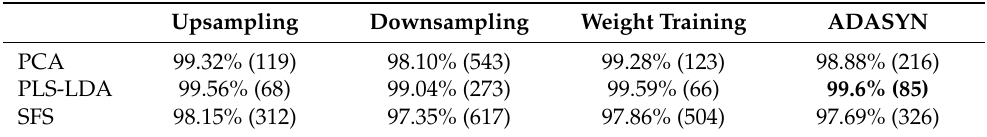
Table 7. Balanced accuracy score and the number of misclassified samples (values in parentheses) for predicting different types of APS (Non-Stress/Mental Stress/Emotional Anxiety Stress).